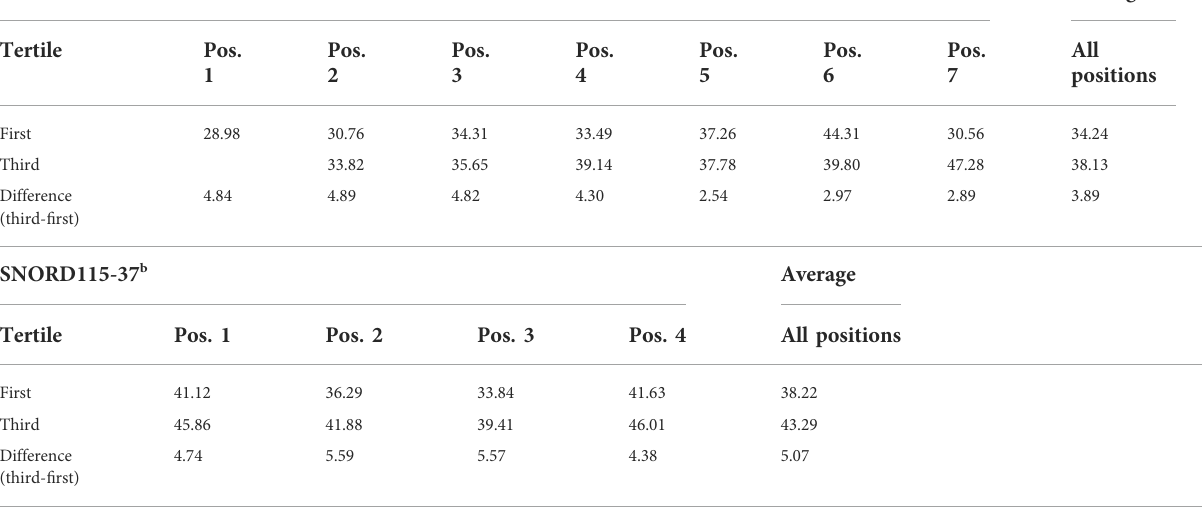
TABLE 5 Differential methylation of SNORD115-30 and SNORD115-37 by DDE tertile validated by pyrosequencing analyses. SNORD115-30 a